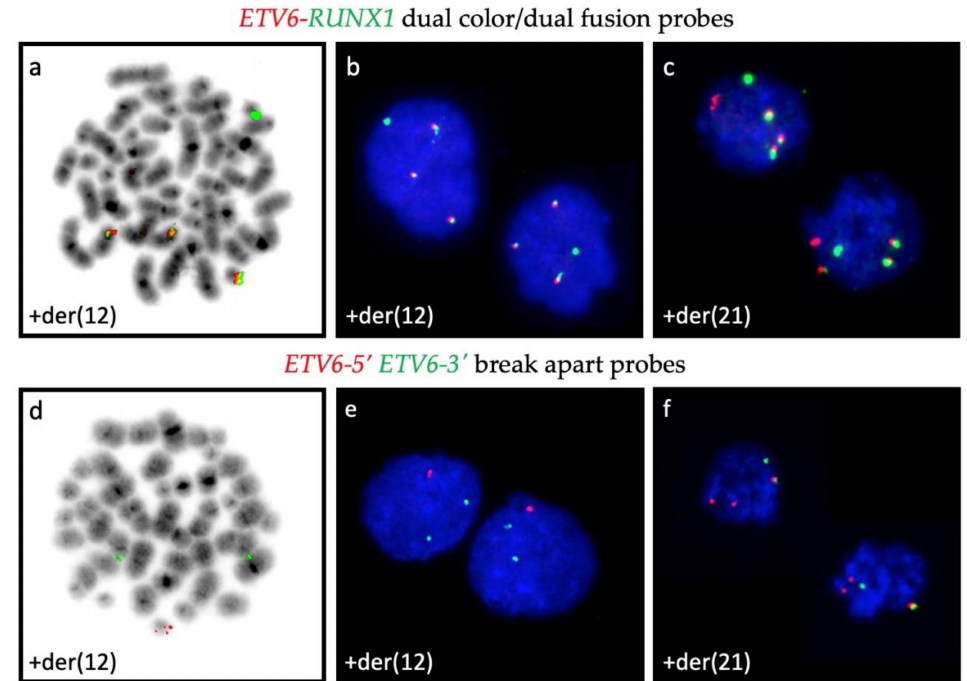
Figure A1. Representative examples of signal patterns that are obtained with different combinations of ETV6 - and RUNX1 - specific FISH probes. ETV6-RUNX1 dual color/dual fusion probes are the preferred way to enumerate the fusion products (3 copies each in metaphase ( a , d ) and interphase ( b , c )) as well as to identify deletions of entire normal alleles (solitary red signal of the residual ETV6 homologue is present in ( c ) but missing in ( a , b )), whereas in interphase cells is not possible to define whether the respective fusion signals represent a der(21) or a der(12) ( b , c ). This issue is only resolvable with the application of dual color ETV6 -5 (cid:48) and 3 (cid:48) break apart probes, which help to unambiguously define the der(12) and the der(21) ( e , f ).